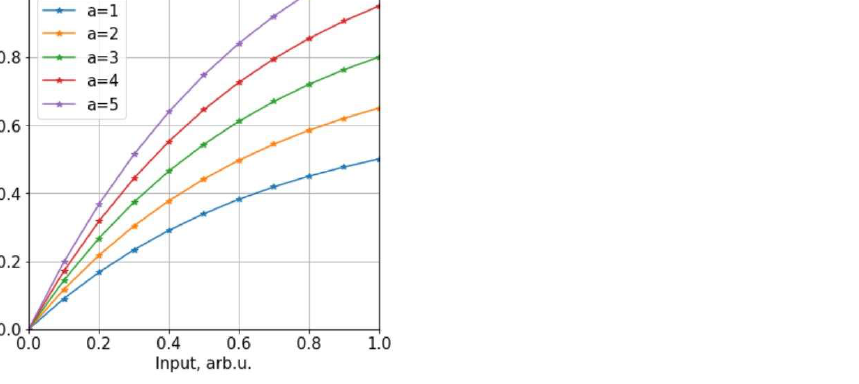
Figure 5. Non-linear scaling function with different coefficient values (arb.u. = arbitrary units).